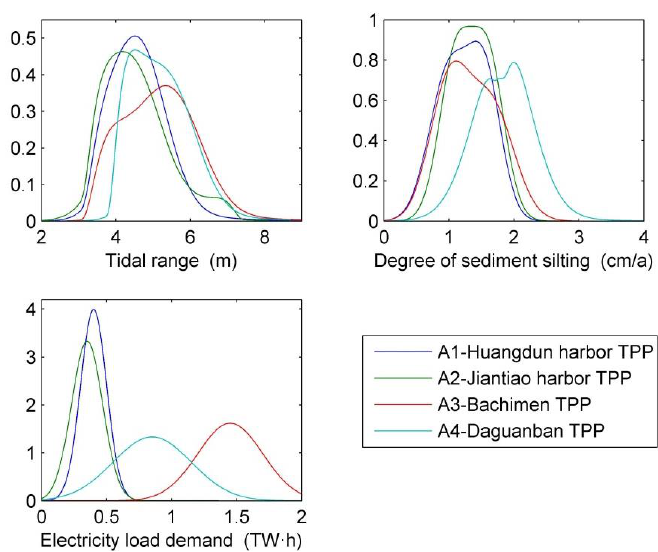
Figure 4. Curve of the distributions function for the criteria which forms are random number.